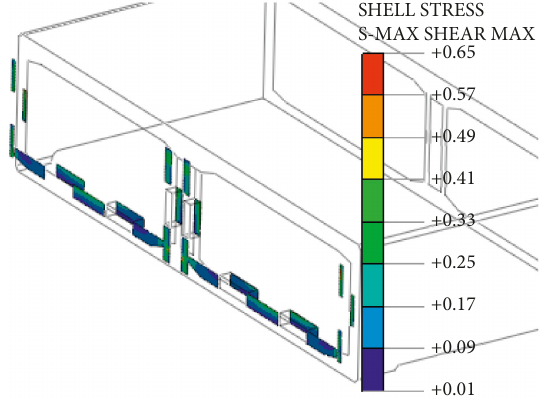
Figure 24: The shear force on joint 2 under different working